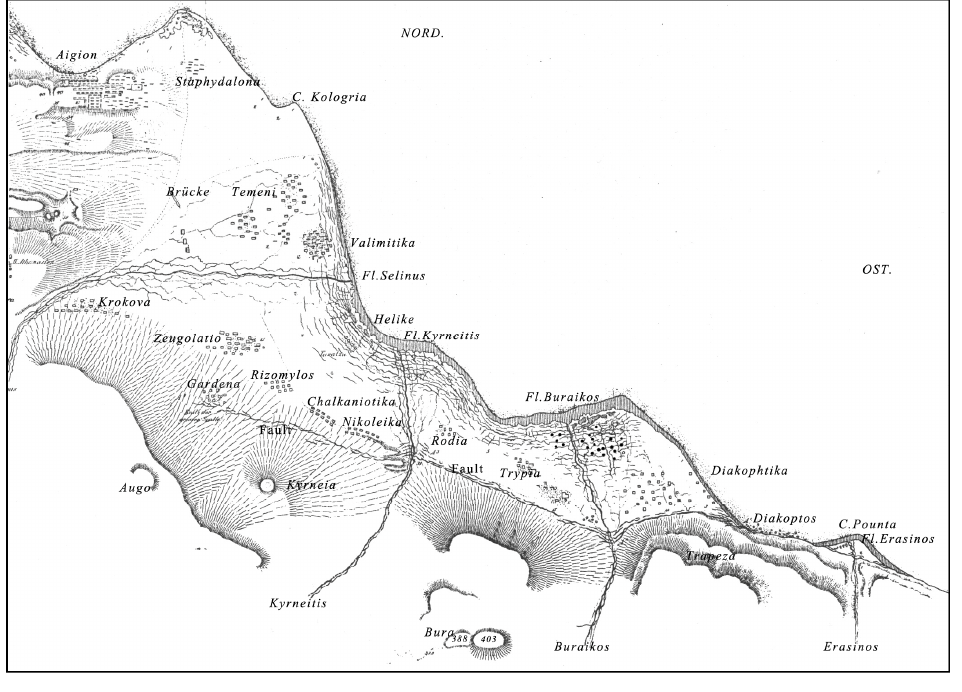
Figure 8. Reproduction of the original map of Schmidt’s map of the Helike Delta, drawn a month after the earthquake of December 1861 [31]. A fault crack extends along the base of the hills from Pounta to Gardena (modern Keryneia). The shaded fringe by the shore represents the area submerged by the earthquake. Extensive fissuring occurred all along the shore, and sand volcanoes (solid circles) were concentrated on the delta of the Vouraikos River.